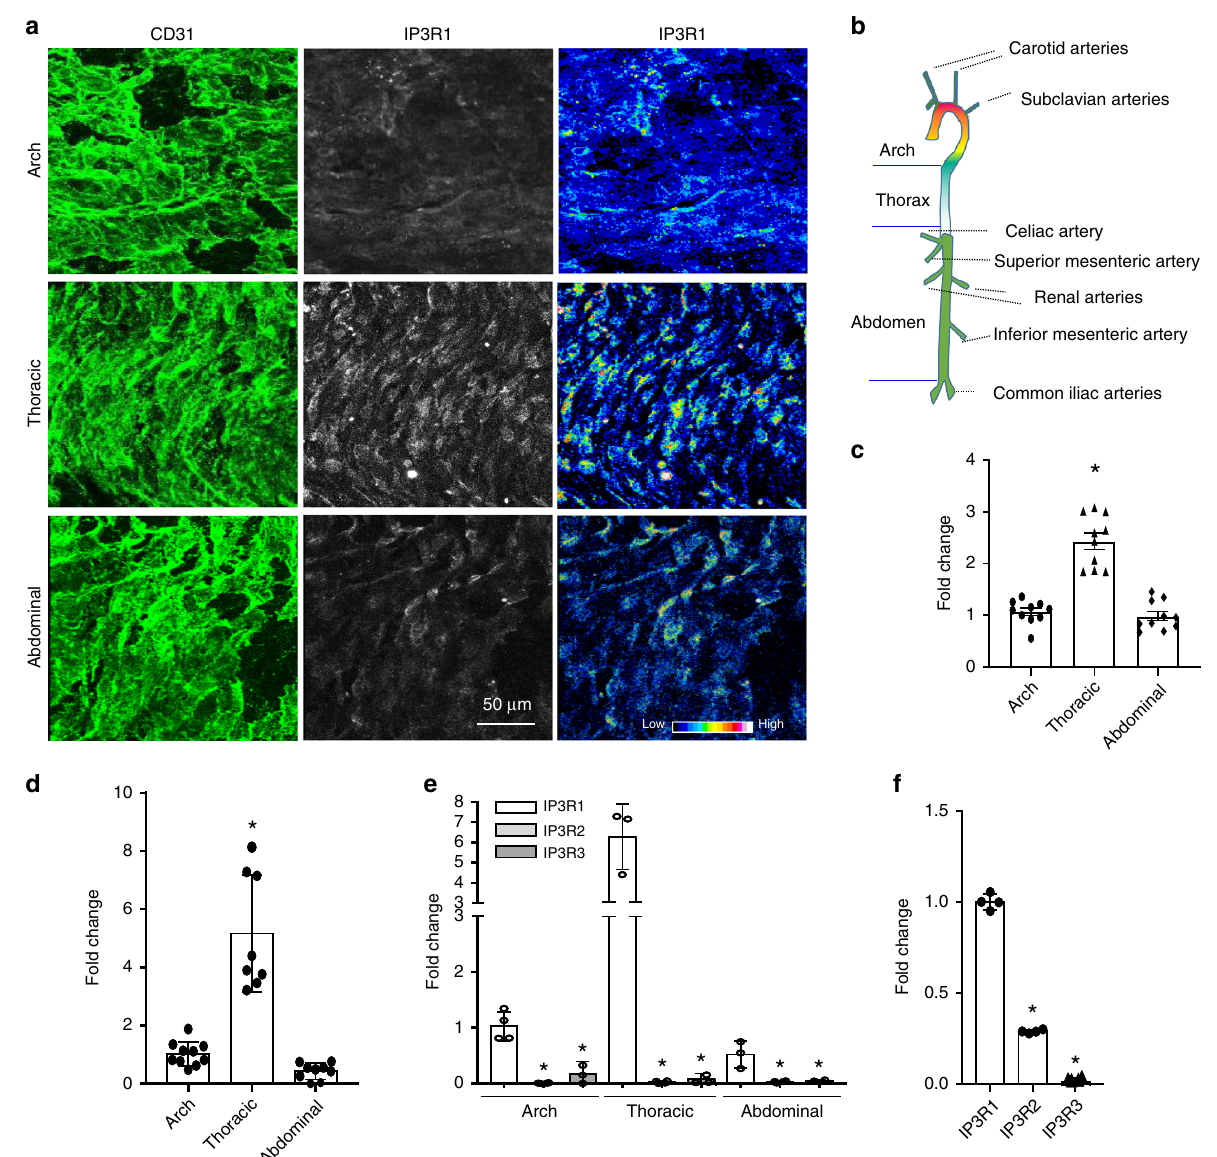
Fig. 6 Abundance of IP3R1 in different regions of the aorta. a Whole mount en face immuno fl uorescence staining, followed by confocal imaging. 0.5 μ m optical sections of the endothelium were imaged. CD31 staining shows the endothelial cell surface and IP3R1 staining of the same optical sections is shown (left and center panels). The fl uorescence intensity of IP3R1 staining of sections from the aortic arch, thoracic aorta, and abdominal aorta is also depicted (right panels). b A schematic diagram of the aorta highlighting the regions of analysis. c Quanti fi cation of IP3R1 immuno fl uorescent staining distribution in aortas (thoracic aorta vs. aortic arch and abdominal aorta, n = 10 microscopic fi elds captured for each segments, asterisk P < 0.01). d RT-PCR analysis of IP3R1 abundance in the aortic arch, thoracic aorta, and abdominal aorta (thoracic aorta vs. aortic arch or abdominal aorta, aortic RNA from seven mice was extracted for qPCR analysis, 4 repeats in each reaction, asterisk P < 0.0001). e, f Abundance of IP3R1, IP3R2, and IP3R3 mRNA in the aortic arch, thoracic aorta, and abdominal aorta. RNA was extracted from aortas of seven mice for qPCR analysis, and 4 repeats ( e ) in each reaction or in MAECs ( f ). (IP3R1 vs. IP3R2 and IP3R3, n = 3 independent experiments, asterisk P < 0.0001). All data were assessed using Student ’ s t -test and are presented as the mean ±